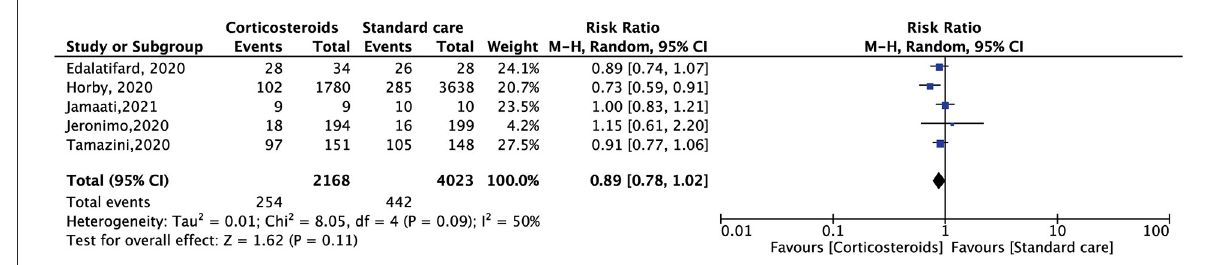
FIGURE4 Forest plot of comparison: demand for oxygen support.